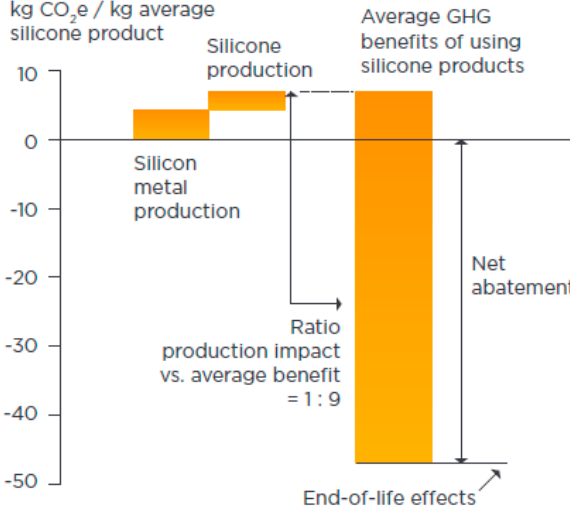
Figure 8. GHG benefits of using silicones [37]. Table 8. Bond strengths at the interface [35].